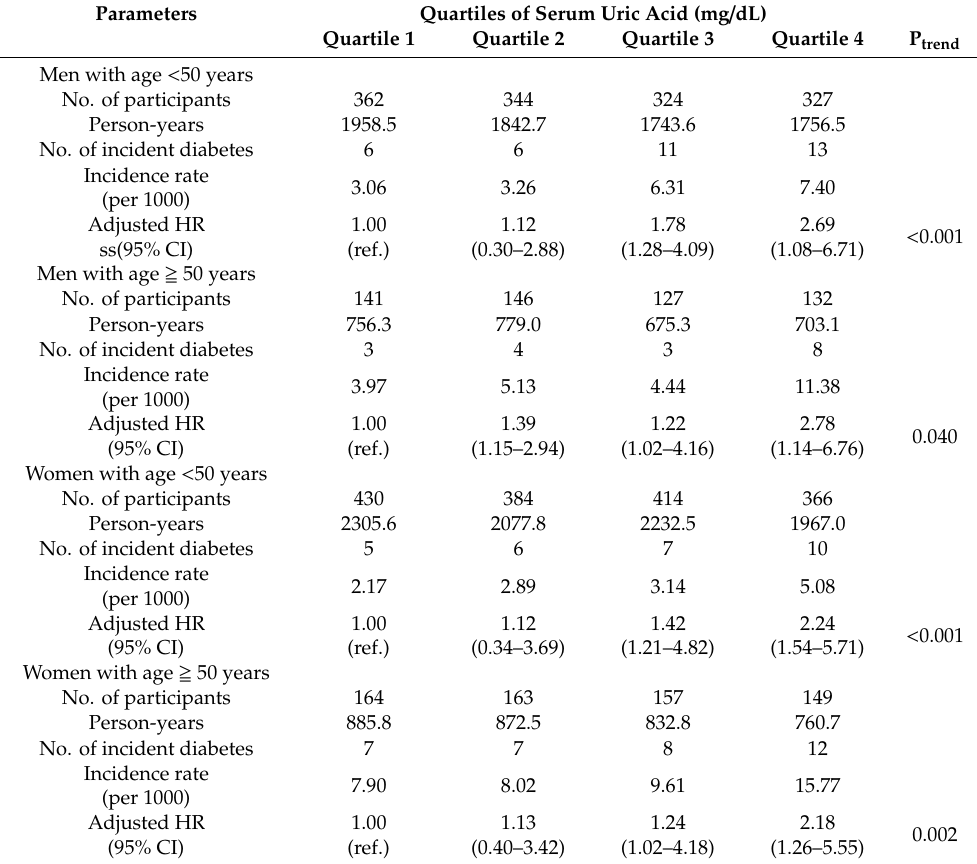
Table 3. Subgroup analyses of the association between serum uric acid levels and risk of type 2 diabetes by sex and